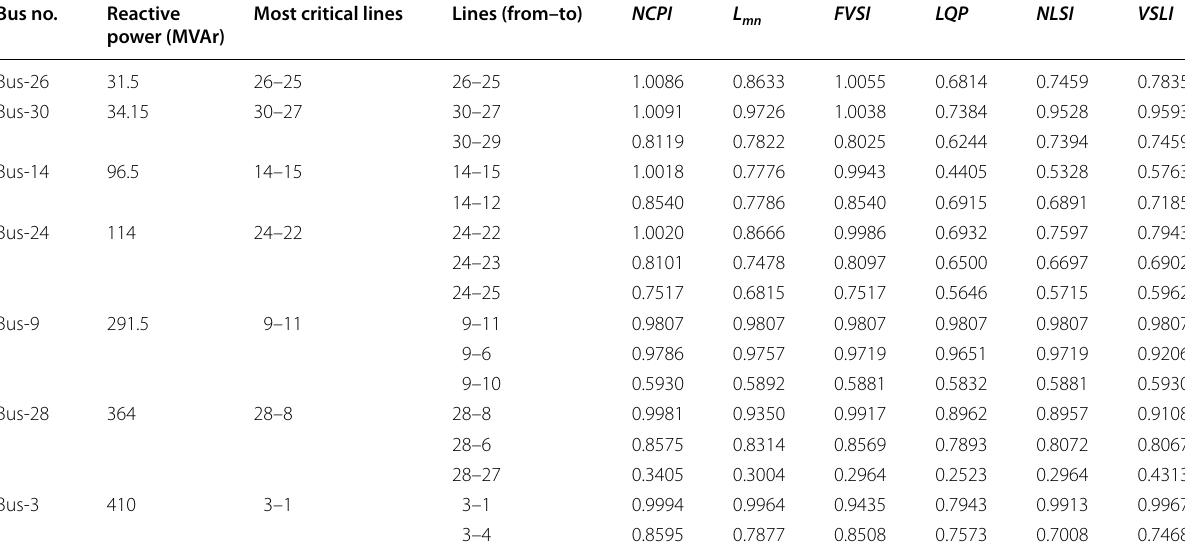
Table 3 Heavy reactive power at some load buses of the IEEE 30-bus test system Bus